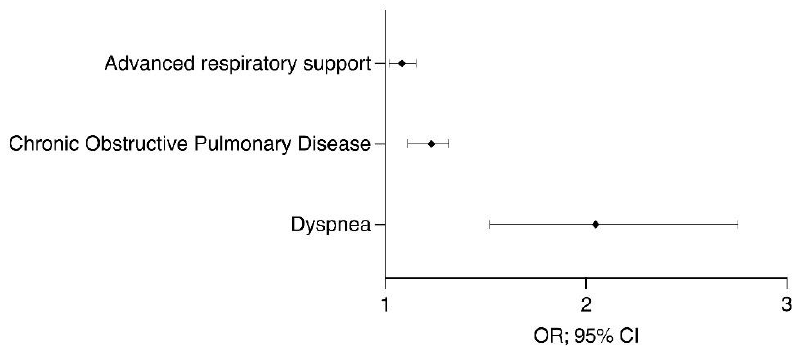
Figure 1. Factors associated with the presence of neurological symptoms. OR: odds ratio; CI: confidence interval.